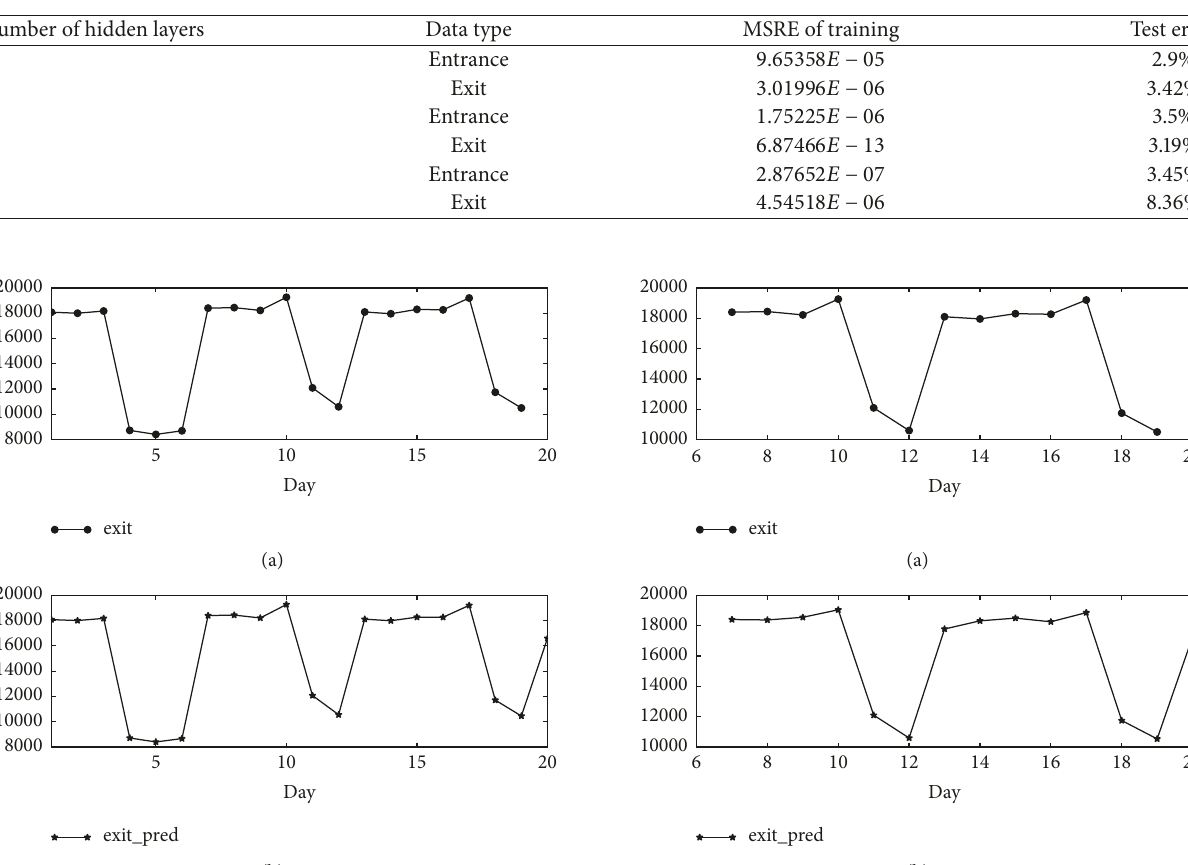
Table 8: Comparison among tests with one hidden layer, two hidden layers, and three hidden layers.